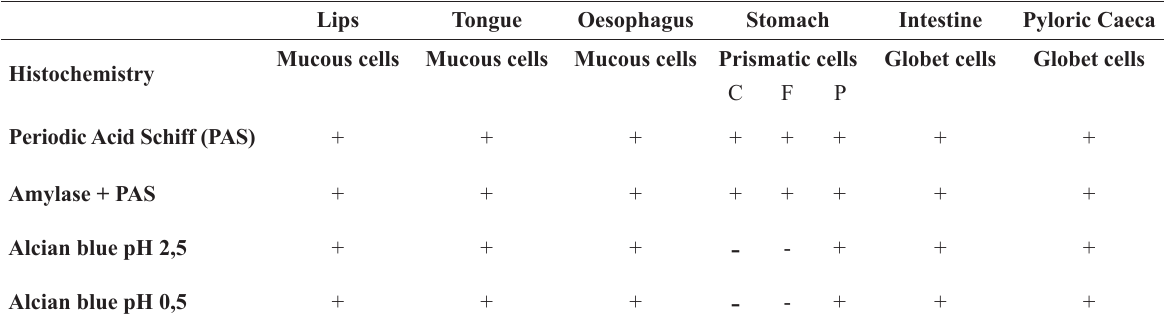
Histochemical characteristics of secretion present in digestive